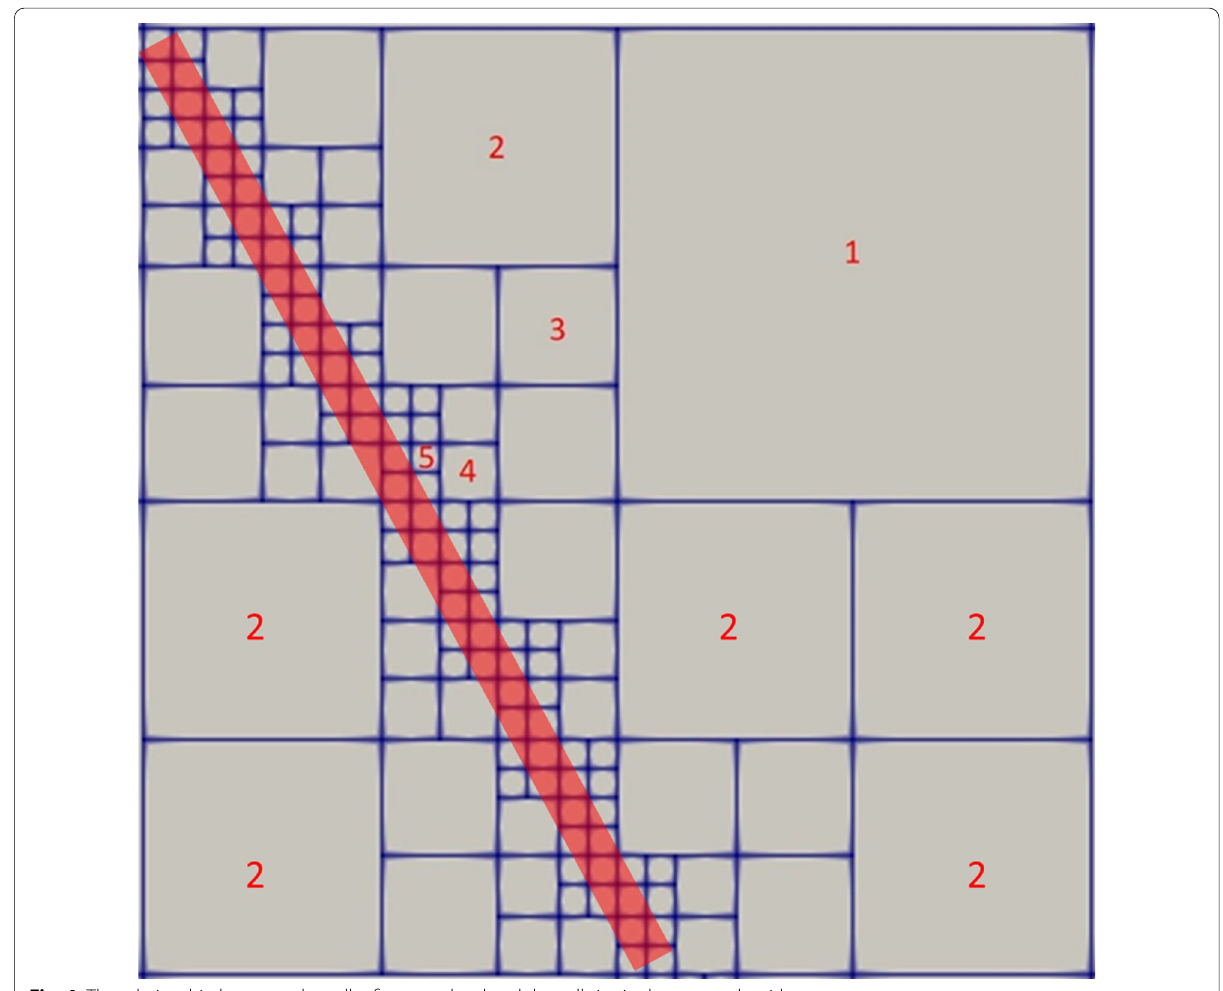
Fig. 4 The relationship between the cell refinement level and the cell size in the octree algorithm